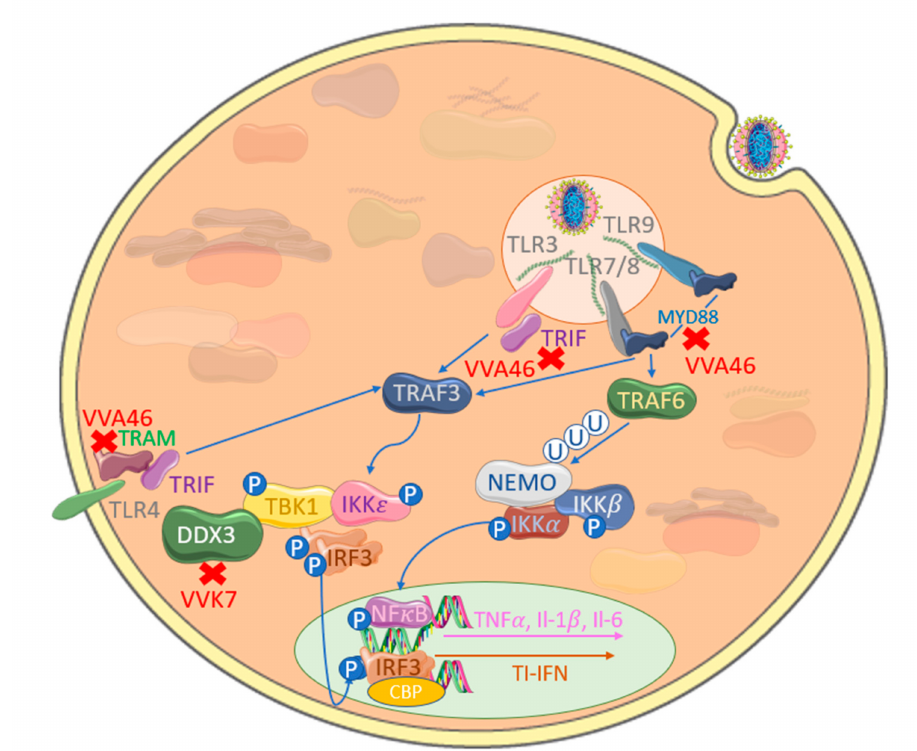
Figure 3. TLR adaptor-targeting by poxviruses inhibits TLR-mediated IRF activation. VACV-encoded A46 (VVA46) interacts with the Toll Il − 1R (TIR) domain of MyD88, TRIF and TRAM, inhibiting